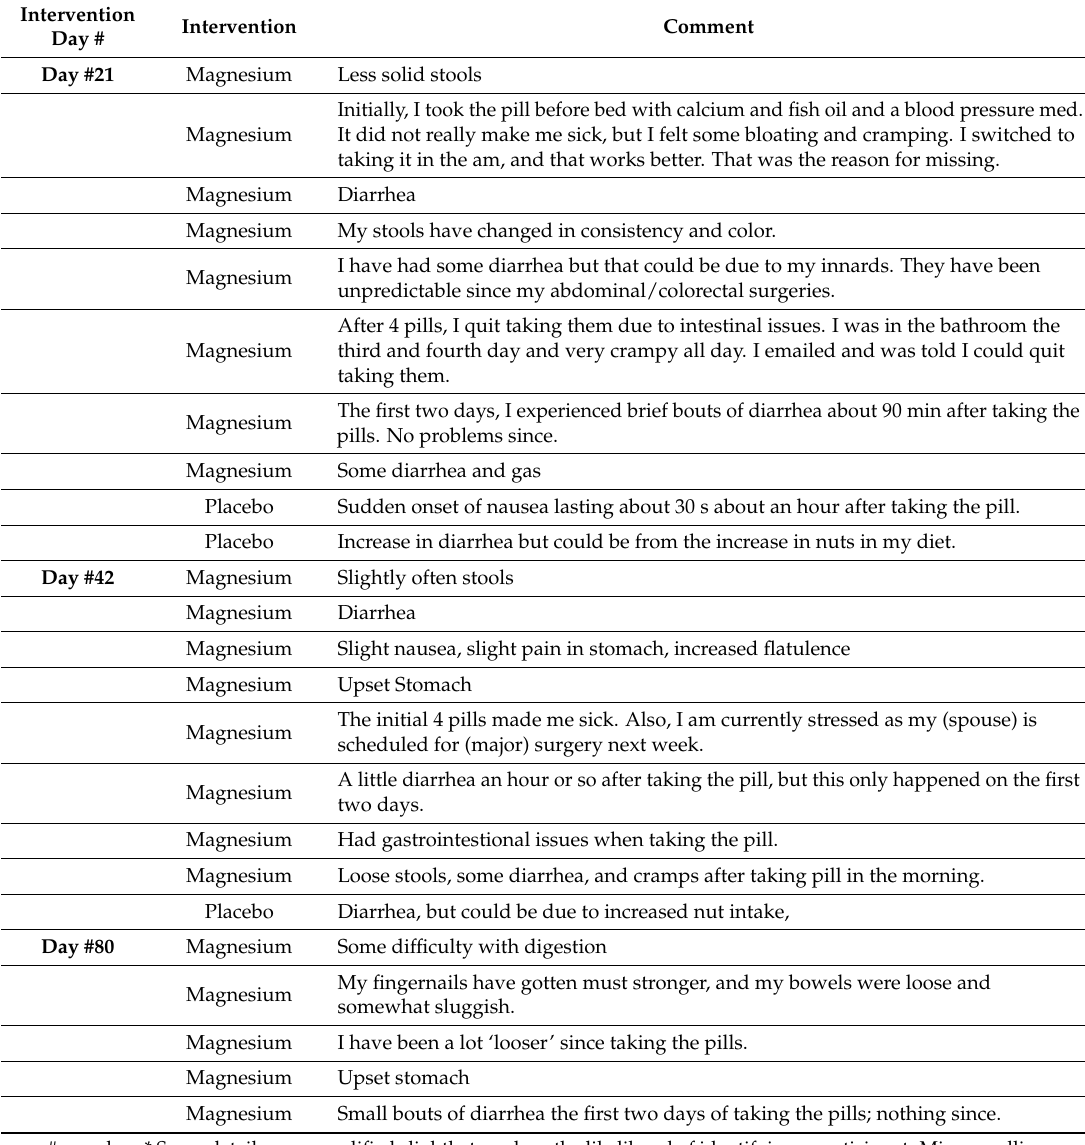
Table 5. Gastrointestinal (GI)-related responses to the open-ended question, “Since starting the study, have you experienced anything out of the ordinary?”